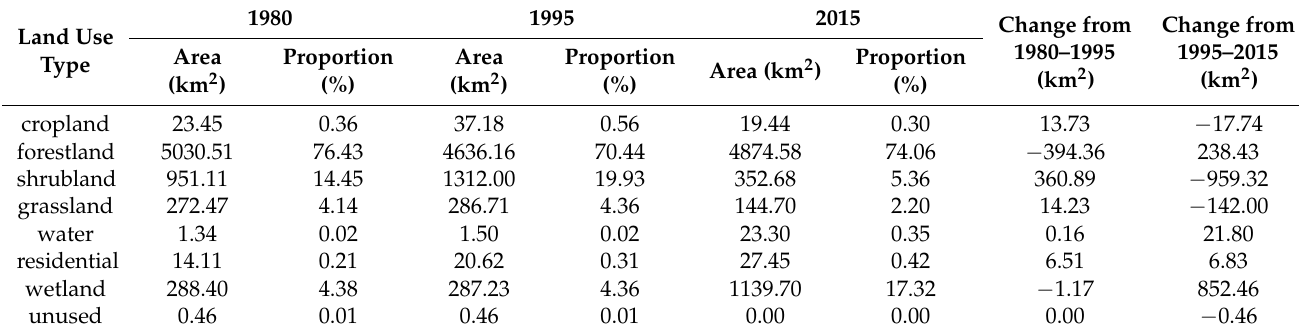
Figure 5. Simulation of annual runoff under extreme land-use scenarios.